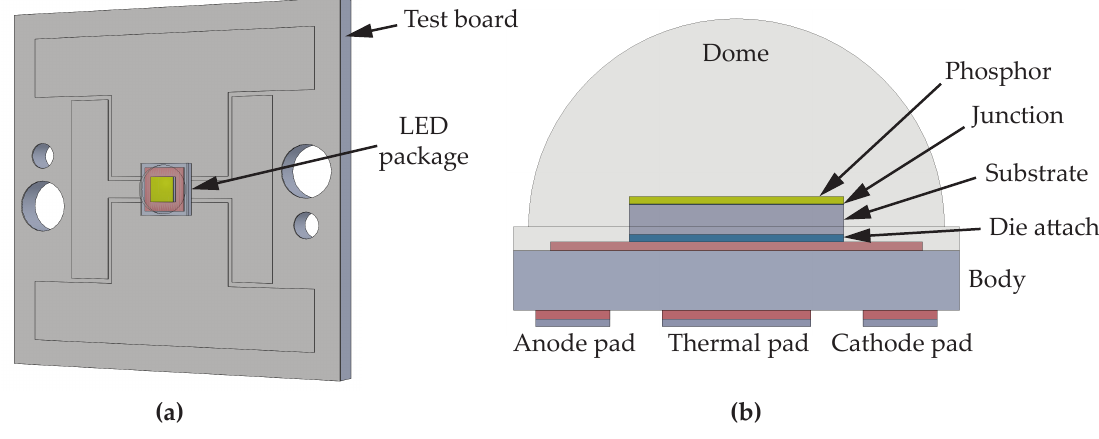
Figure 2. Detailed geometry of the LED under investigation: ( a ) The LED package assembled on the test board (DUT). ( b ) Cross-sectional view of the LED package